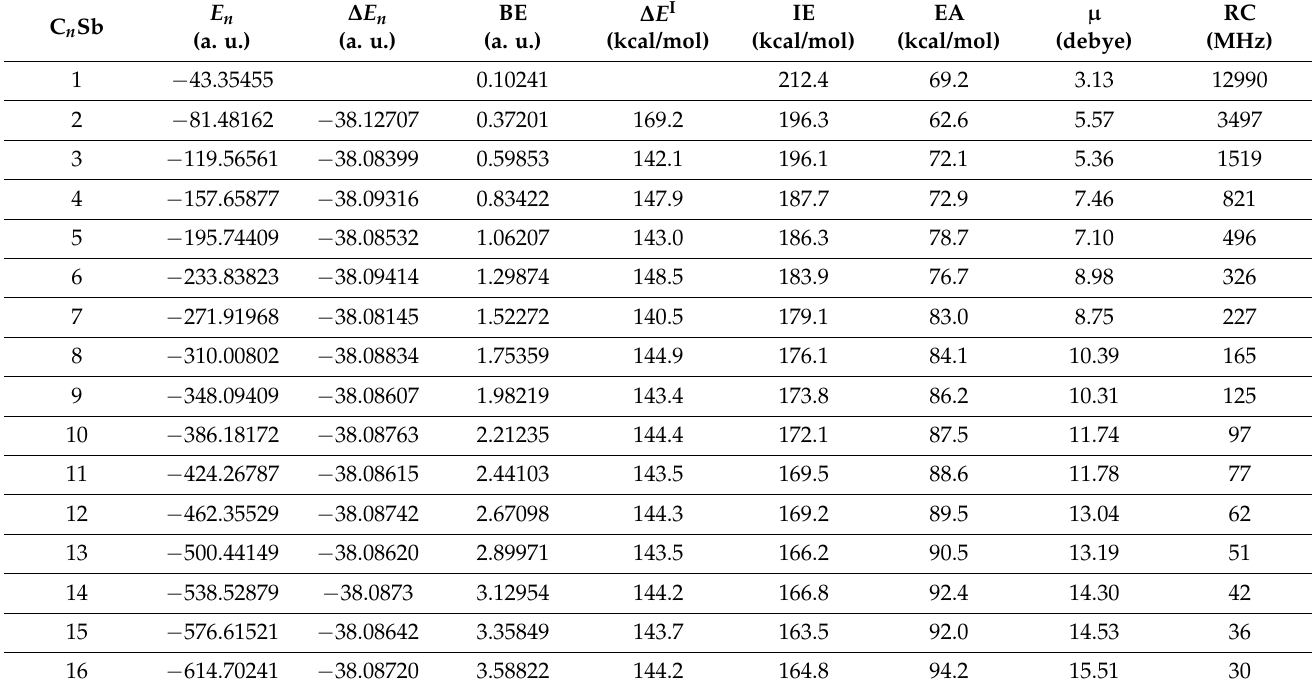
Figure 6. C-Sb bond length of neutral C n Sb, C n Sb + cation, and C n Sb − anion as a function of number of carbon atoms. Table 4. The total energies E n , differential energies ∆ E n , incremental energies ∆ E I , binding energies BE, adiabatic ionization energies IE, adiabatic electron affinities EA, dipole moments, and rotational constants (RC) of neutral C n